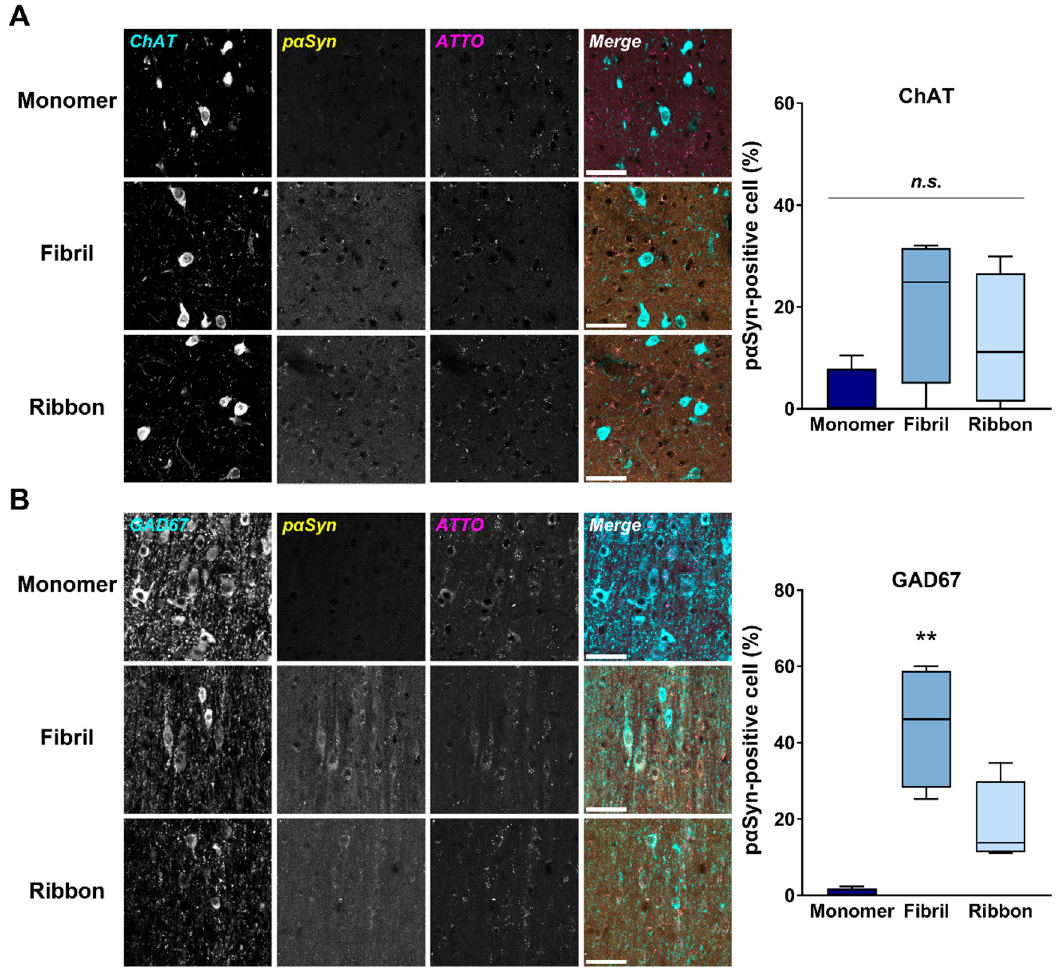
Figure 4. Accumulation of p α Syn in septal GABAergic neurons after intrastriatal injection of α Syn. ( Left ) Representative images of phosphorylated α Syn (p α Syn; yellow) accumulation and exogenously applied α Syn (ATTO; magenta) in ChAT- positive ( A ) and GAD67-positive ( B ) cells (cyan) in the MS/DB, 30 days after the injection. Scale bar: 50 μ m. ( Right ) Quan- titative analyses of the ratio of p α Syn-positive cells in ChAT-positive ( A ) and GAD67-positive cells. ** p < 0.01 vs. mono- meric α Syn-injected group ( n = 4 per group).